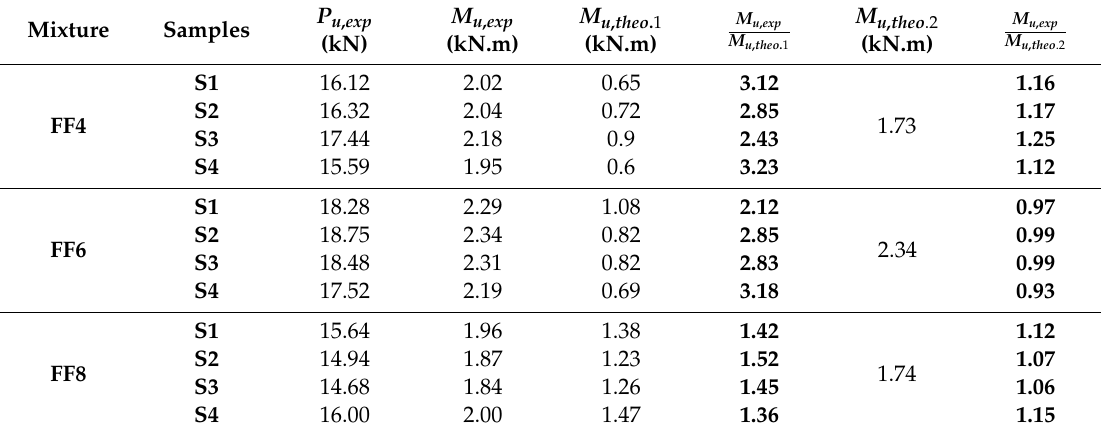
Table 9. Experimental and theoretical moment capacity of twisted-bundle macro-synthetic fiber reinforced SCC